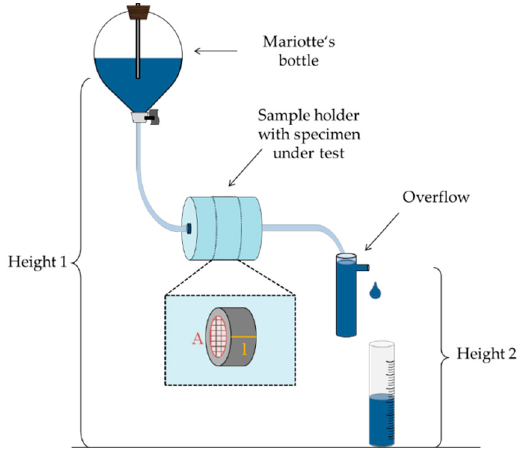
Figure 1. Experimental setup for permeability measurement ensuring defined hydrodynamic conditions.